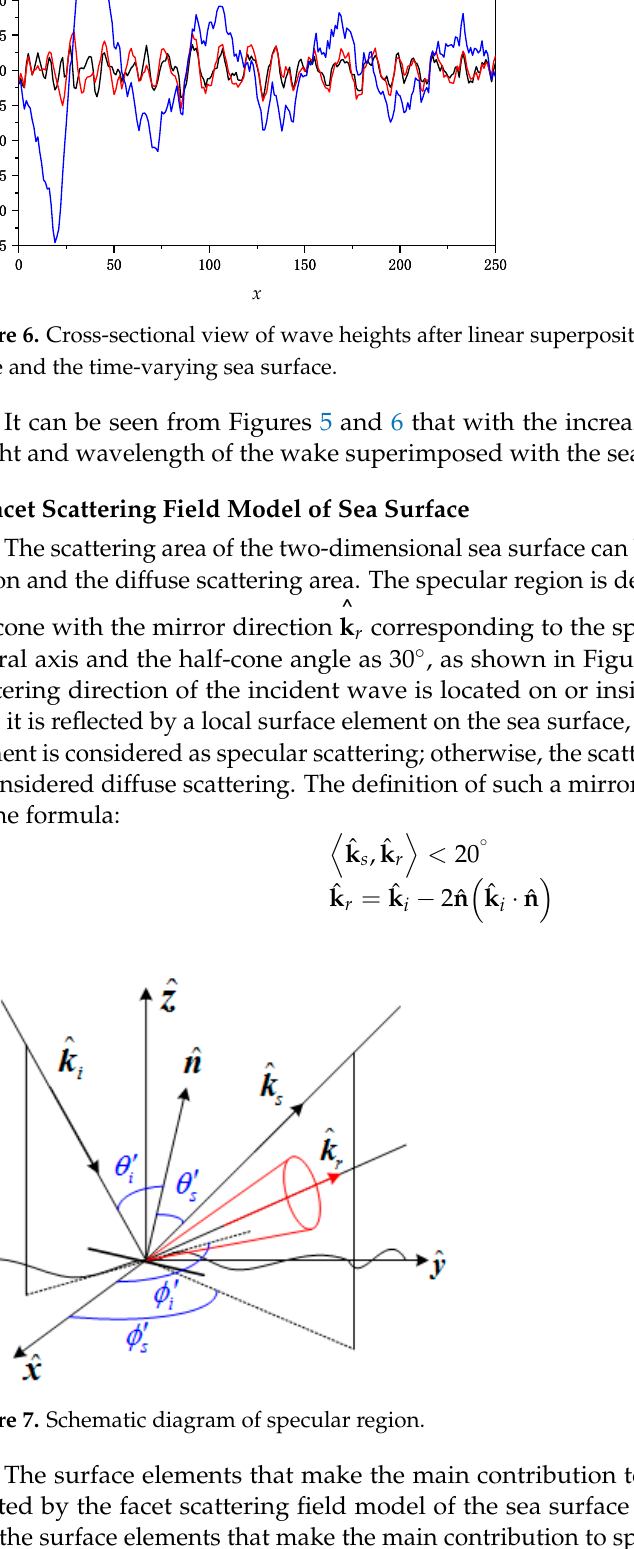
Figure 5. Wave height after linear superposition of time-varying Kelvin wake and time-varying sea surface for ( a ) U s = 5 m/s and ( b ) U s = 10 m/s.